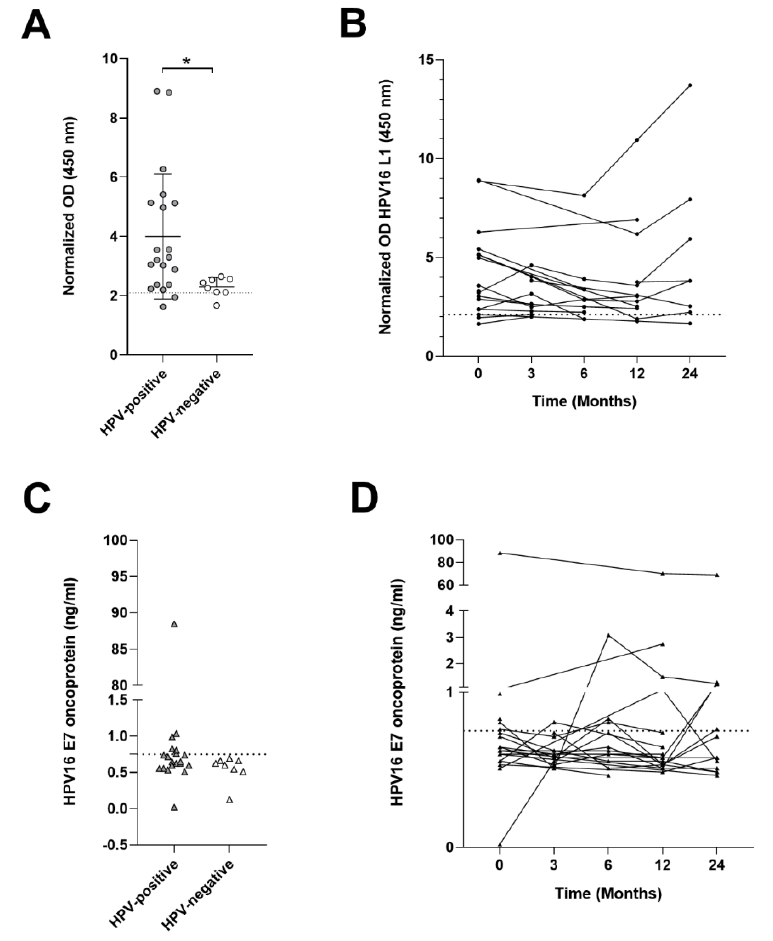
Figure 2. ELISA tests on HNSCC serum samples. Statistical significance was indicated as *